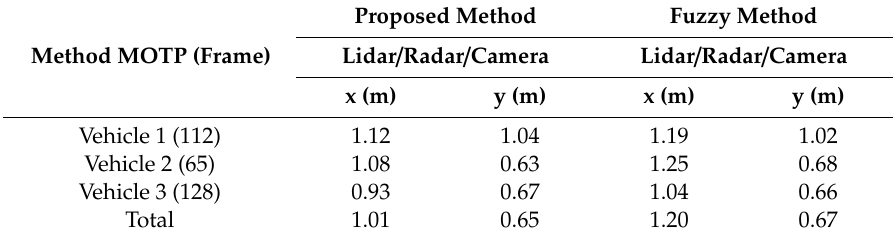
Table 4. Comparison of the results of the proposed method with fuzzy method in Scenario 1.